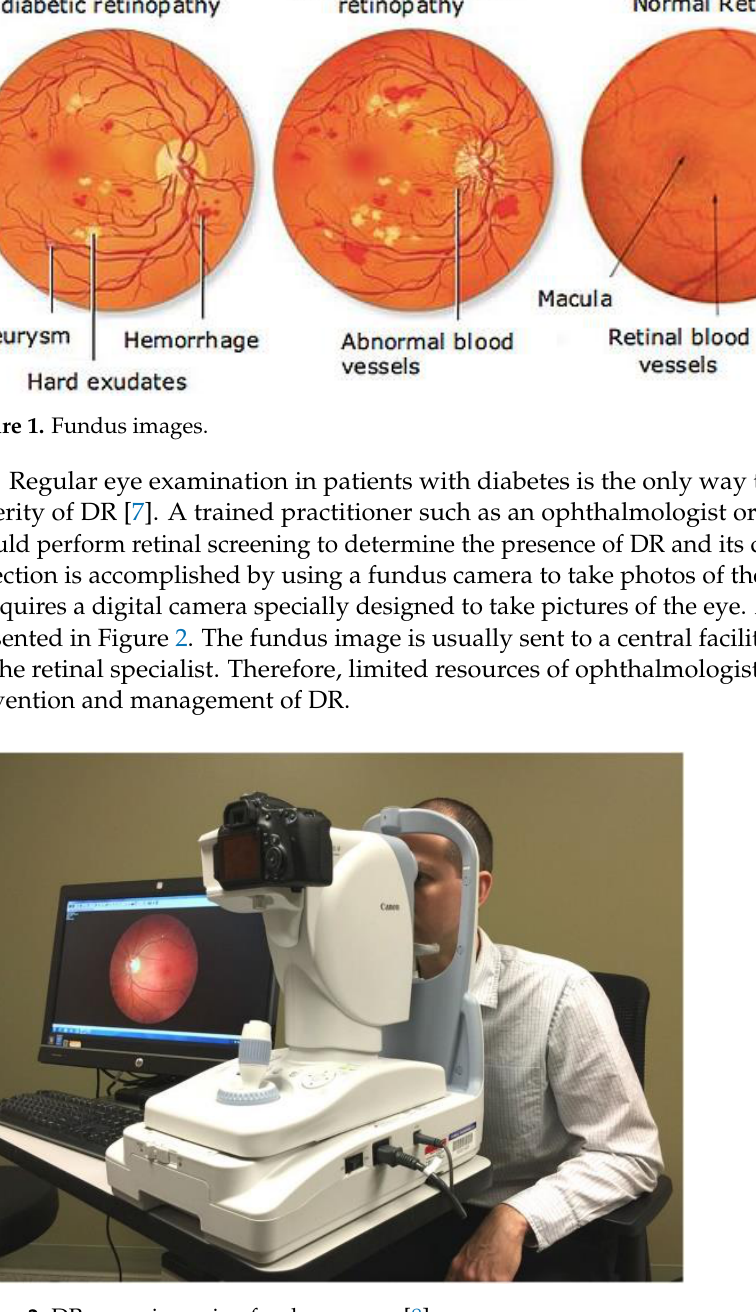
Figure 2. DR screening using fundus camera [8] .